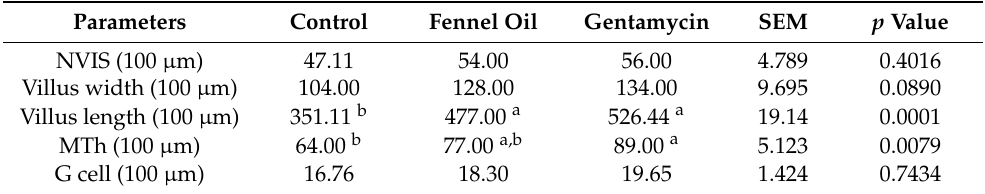
Table 9. Impact of dietary fennel oil or gentamycin on morphology of intestinal weaned Moshtohor rabbits aged 12 weeks.